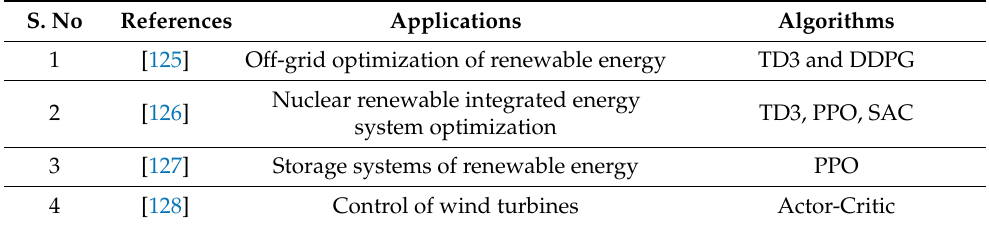
Table 6. Reinforcement learning application of renewable